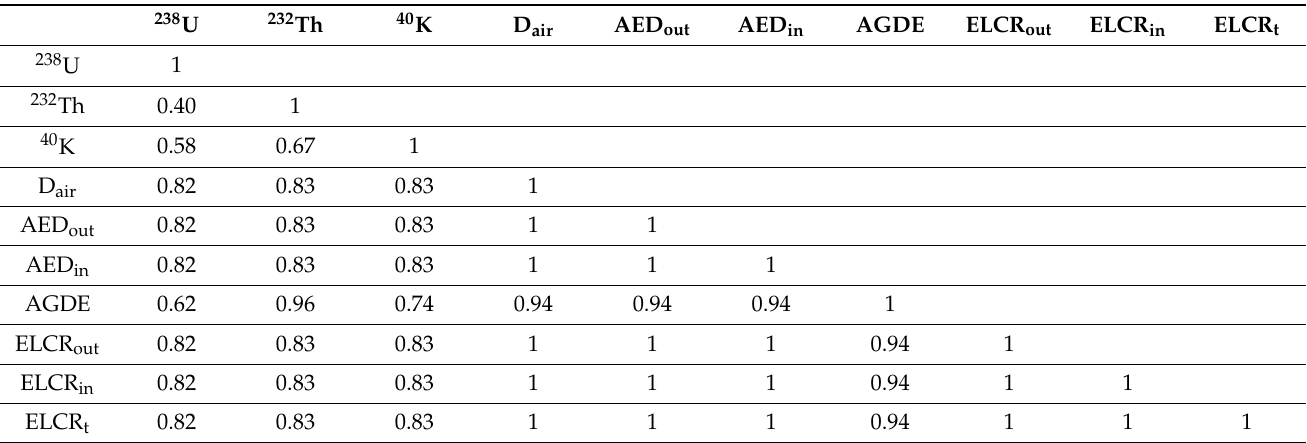
Table 5. The Pearson correlation matrix (PCM) of 238 U, 232 Th, 40 K activity concentrations and the radiological variables of syenogranite.